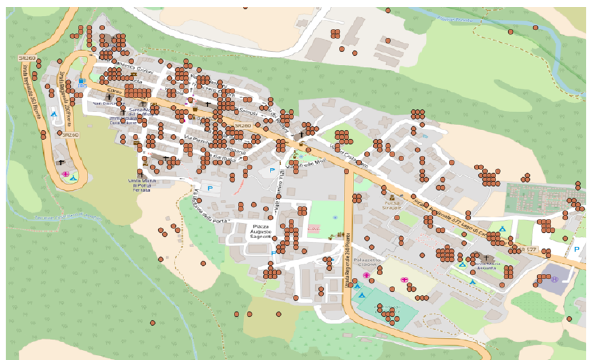
Figure 5. CCD results visualization for the ascending-pass stack (area of Amatrice), basemap by OpenStreetMap